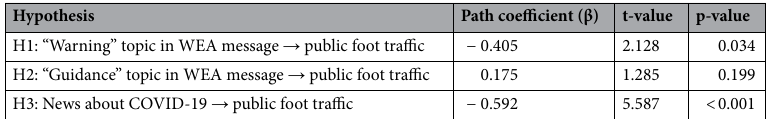
Table 5. Results of the path coefficients with t-value and p-value for the PLS-SEM. PLS-SEM, partial least squares structural equation modeling; WEA, wireless emergency alerts.